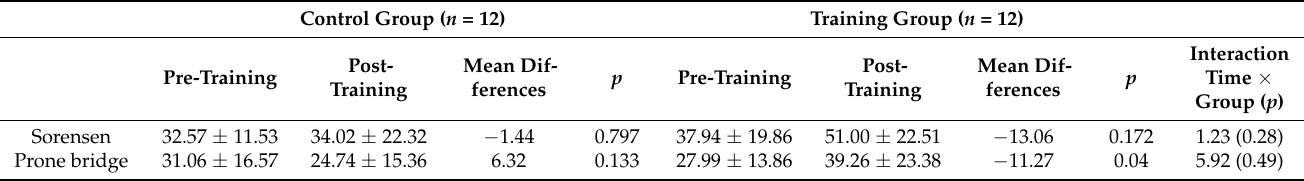
Table 5. Performance in McGill test.